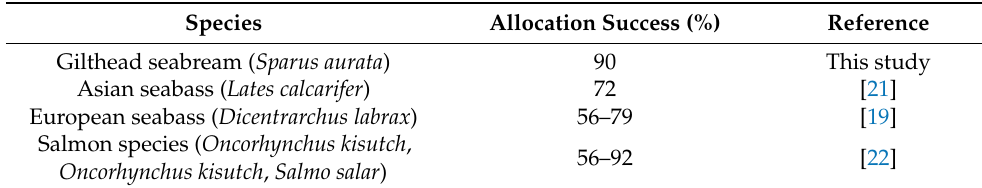
Table 5. Production method traceability studies based only on the elemental fingerprinting of fish muscle. Species Allocation Success